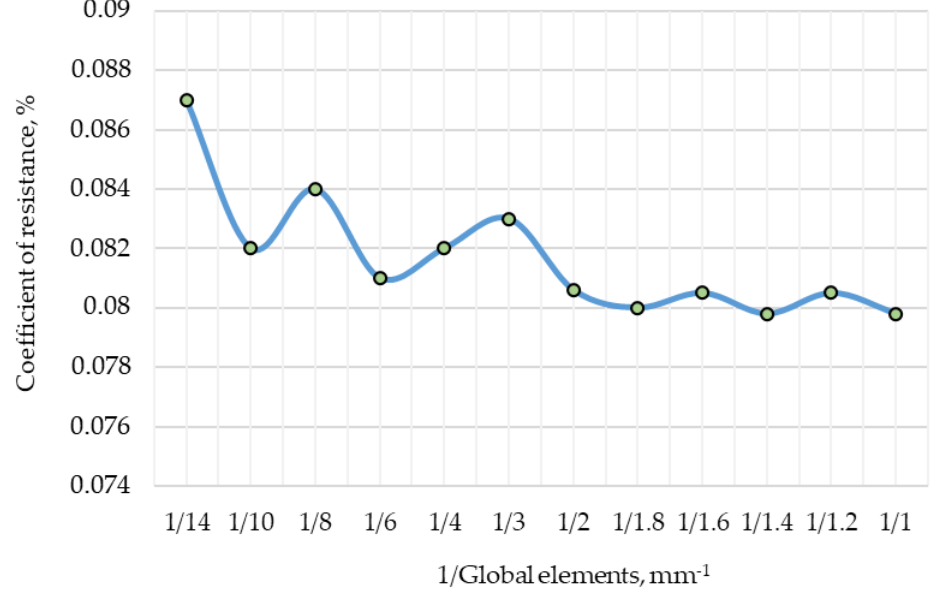
Figure 2. Grid Figure 2. Grid convergence.